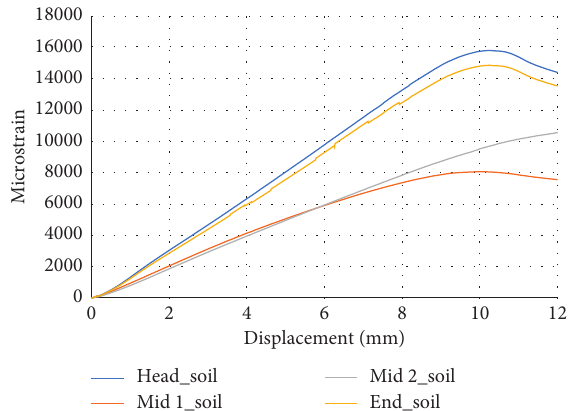
Figure 23: Strain vs. displacement for GFRP rock bolt sensor fixed with soil.